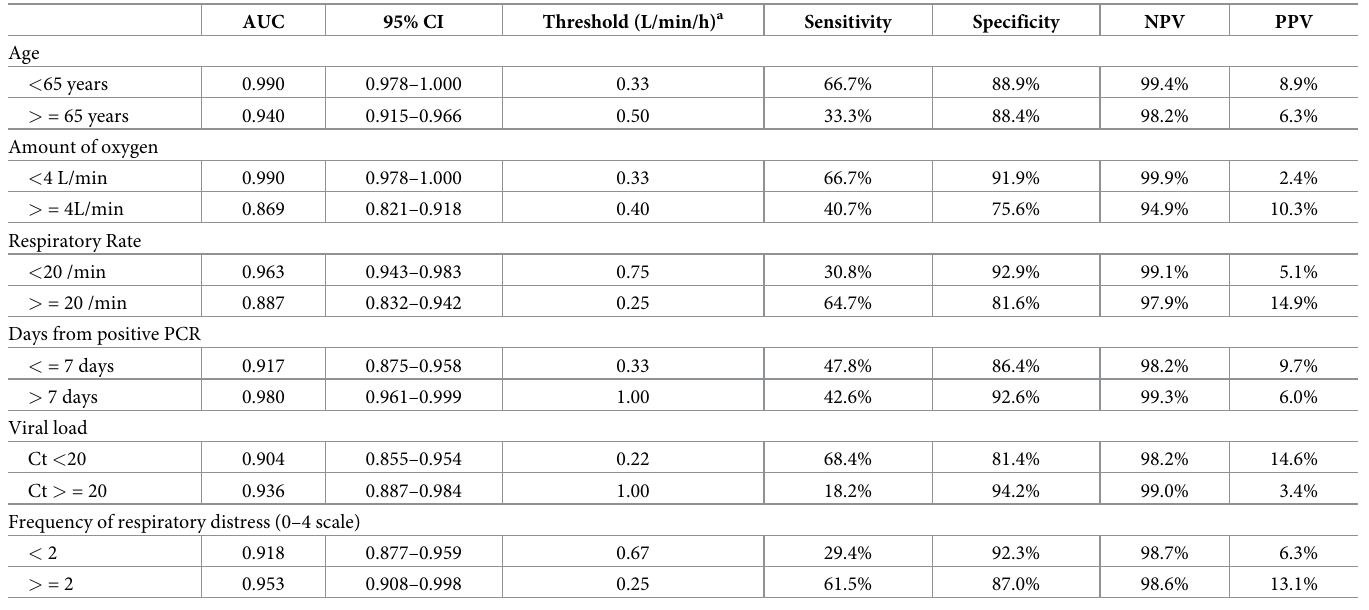
Table 4. Prediction of MV use by increments in oxygen demand in